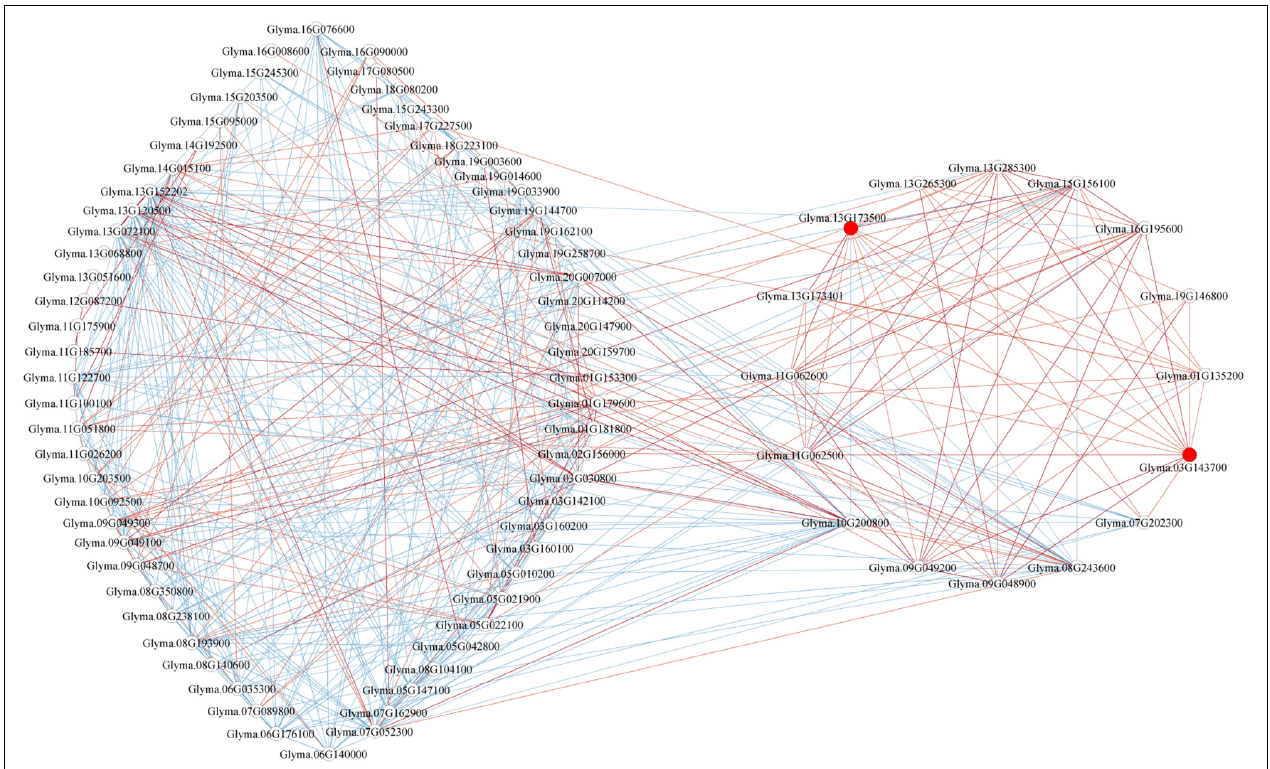
FIGURE 8 | The co-expression network analysis of differentially expressed GmP450s in response to P. sojae infection. In total, 85 GmP450s differentially expressed in at least four transcriptomic studies were included in the analysis. Red and blue lines indicate positive and negative correlation, respectively. Red circles show IFS2 ( Glyma.13G173500 ) and 3 ,9-dihydroxypterocarpan 6A-monooxygenase ( Glyma.03G143700 ).